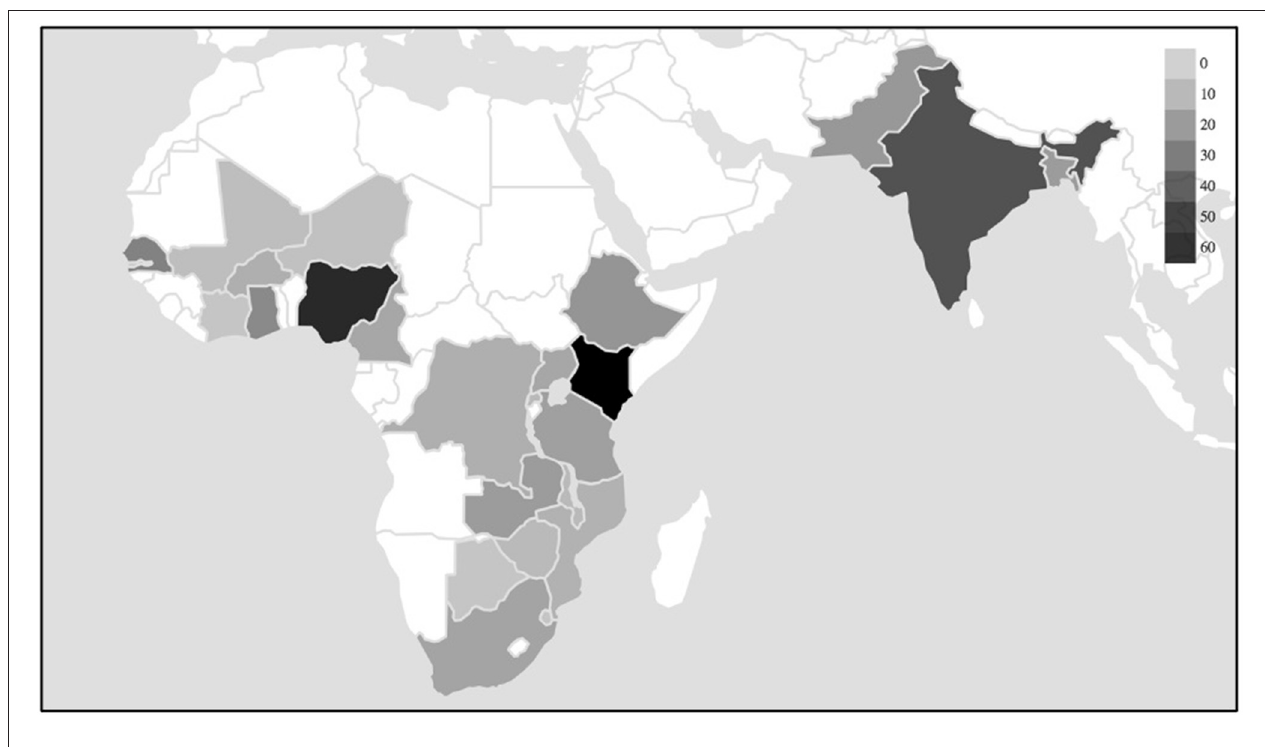
FIGURE 1 | Number of studies, by country.